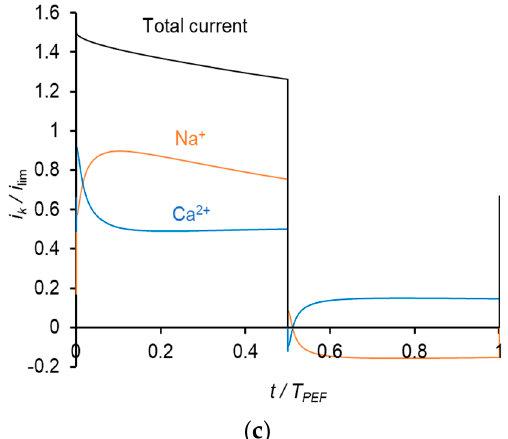
Figure 7. Time dependences of normalized partial current densities of Na + and Ca 2+ ions in PEF mode at a frequency of 0.5 Hz and different U av : U av = 111 mV ( i = 0.3 i lim in CC mode) ( a ); U av = 150 mV ( i = 0.4 i lim in CC mode) ( b ) and U av = 238 mV ( i = 0.65 i lim in CC mode) ( c ). T PEF is the period PEF.